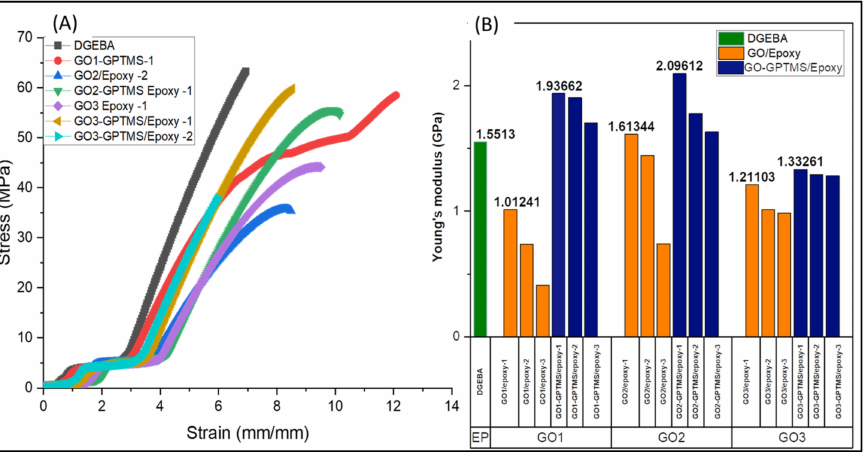
Figure 13. ( A ) Stress strain diagram for nanocompound. ( B ) Young’s modulus of DGEBA, GO/epoxy, and GO-GPTMS/epoxy